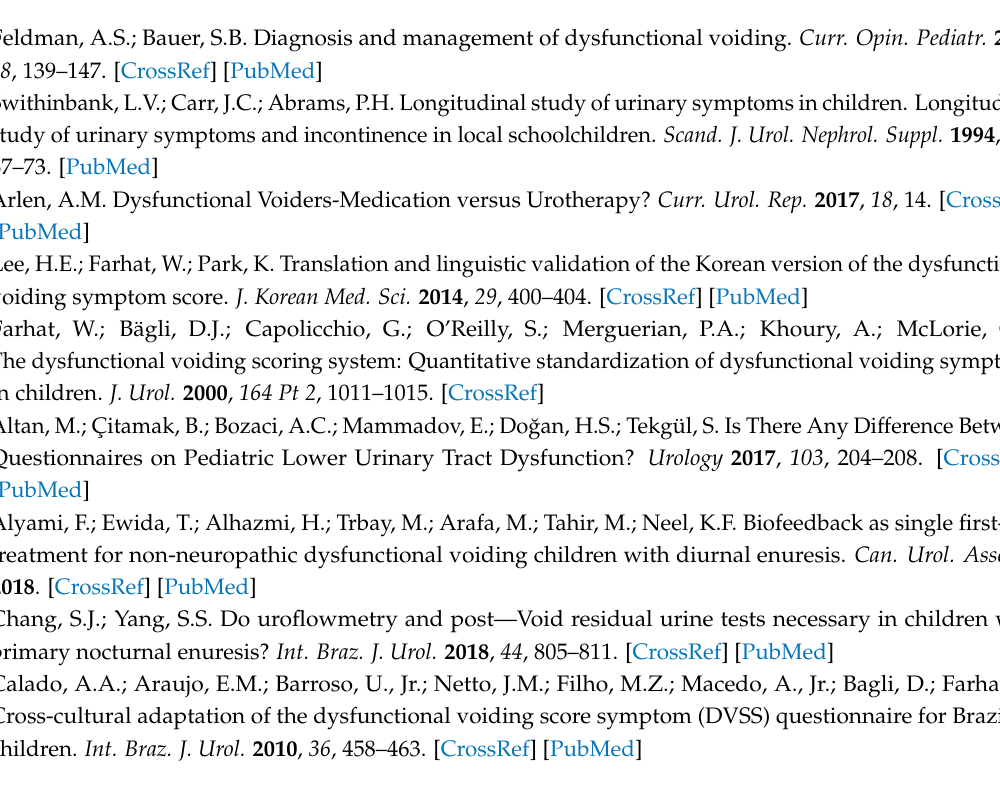
Table S1: Construct validity of the Serbian version of the Dysfunctional Voiding Symptom Score, Table S2. Divergent validity of the Serbian version of the Dysfunctional Voiding Symptom Score, Table S3. Explained variability between gender or and education for each item of the Serbian version of the Dysfunctional Voiding Symptom